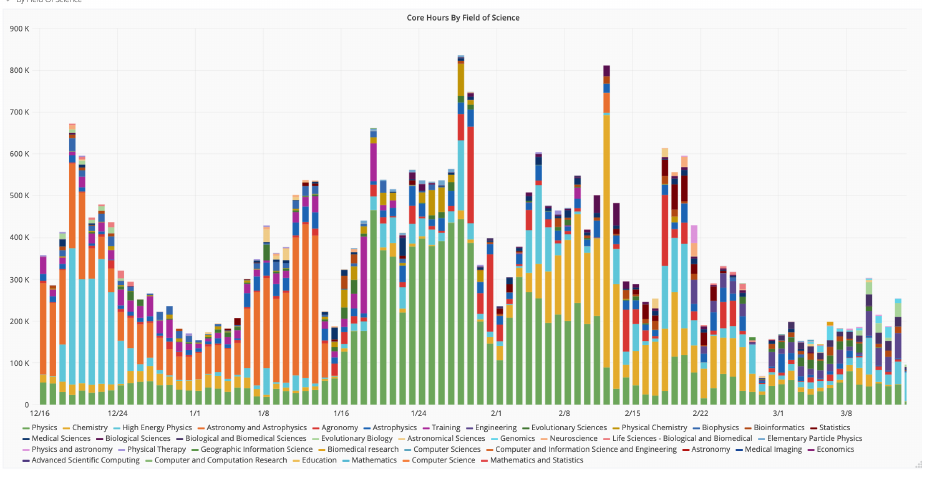
Figure 4: Supported applications on the SSL by science domain when running in backfilling mode for open